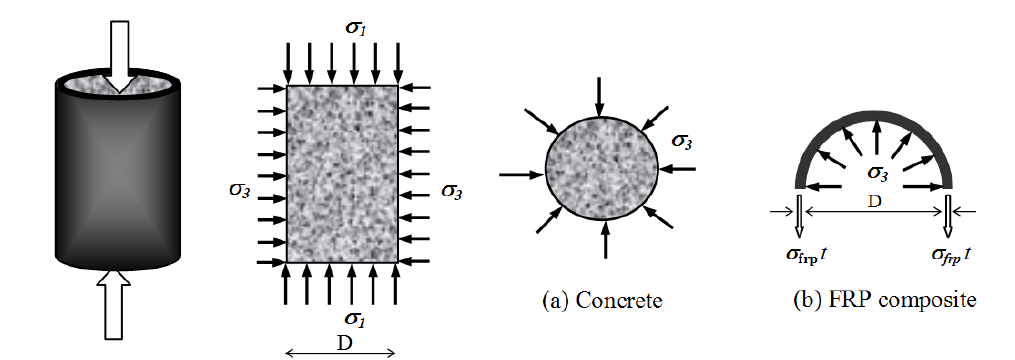
Figure 2. Scheme of confining action for ( a ) concrete; ( b ) Fiber reinforced polymer (FRP)